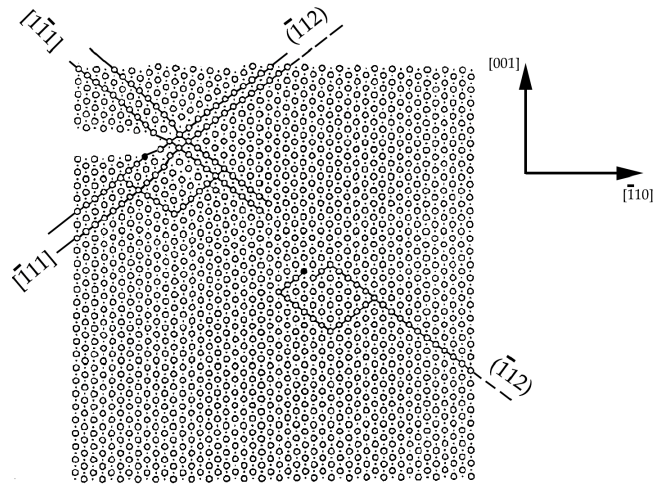
Figure 3. Shielding configuration under quasi-static loading σ A = 1.1 σ G ( σ A —applied stress; σ G —Griffith stress).